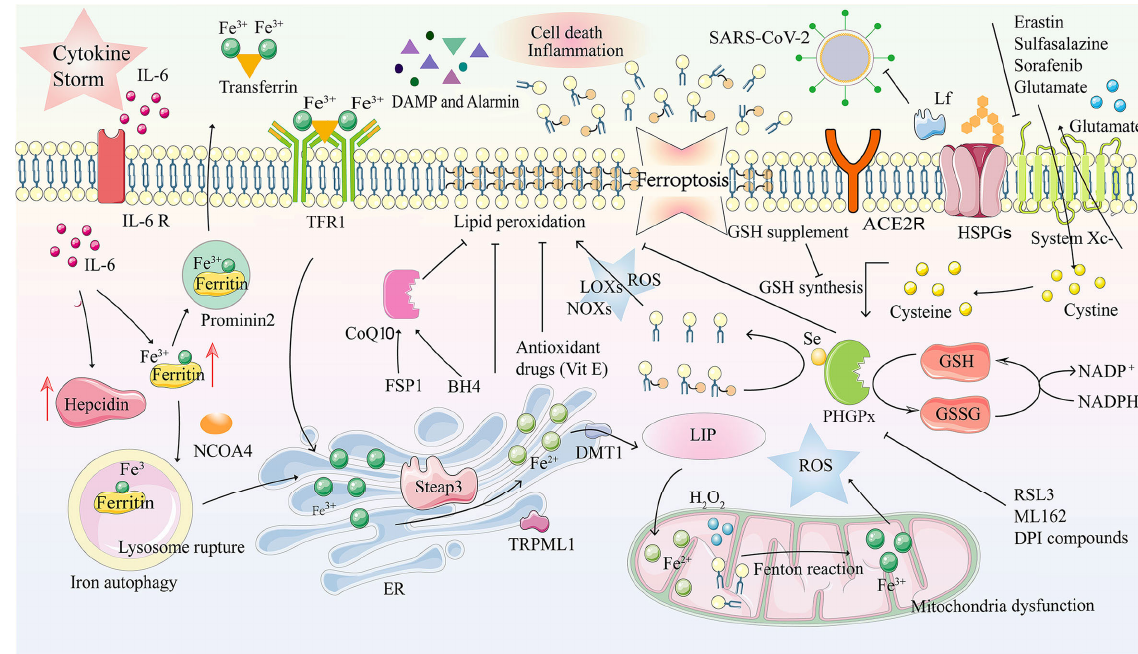
Figure 2. Ferroptosis and its mechanism in COVID-19. Ferroptosis is a kind of programmed cell death characterized by an imbalance in intracellular iron metabolism or a distortion of the glutathione peroxidation pathway. The transferrin receptor recognizes excess transferrin carrying Fe 3+ , and it enters cells through endocytosis after an SARS-CoV-2 infection. Metal reductase Steap3 reduces the Fe ions from trivalent to divalent, while the iron channels DMT1 and TRPML1 in the endosome membrane transport Fe 2+ to the cytoplasm, which is accompanied by iron accumulation. In the case of intracellular iron overload, chemical substances in the mitochondrial electron transfer chain react with H 2 O 2 , Fe 2+ and lipids, together, inducing the Fenton reaction, which produces large amounts of ROS. Due to GPX4 depletion and iron overload in LIP, lipid, nucleic acid and protein peroxidation results in cell membrane damage due to oxidative stress and ferroptosis. DAMPs and Alarmin (HMGB1, IL-33, TNF) are released, eventually aggravating cell death and inflammation. Tf and prominin 2 can effectively excrete the iron from the cells and inhibit ferroptosis. ACE2R, Angiotensin-converting enzyme 2 receptor; ALOXs, arachidonate lipoxygenases; BH4, tetrahydrobiopterin; CoQ10, coenzyme Q10; DAMP, damage-associated molecular patterns; DFO, deferoxamine; DMT1, divalent metal transporter 1; DPI, diphenyleneiodonium; ER, endoplasmic reticulum; FSP1, ferroptosis suppres- sor protein 1; GPX4, glutathione peroxidase 4; GSH, glutathione; GSSG, oxidized GSH; HMGB1, highmobilitygroupbox-1protein; HSPGs, heparan sulfate proteoglycans; H 2 O 2 , hydrogen peroxide; IL, interleukin; Lf, lactoferrin; LIP, labile iron pool; LOXs, lysyl oxidases; NADP + , nicotinamide adenine dinucleotide phosphate; NADPH, nicotinamide adenine dinucleotide phosphate; NCOA4, nuclear receptor coactivator 4; NOXs, NADPH oxidases; PLOOH, phospholipid hydroperoxide; PUFAs, polyunsaturated fatty acids; ROS, reactive oxygen species; RSL3, 1S,3R-RSL3; Se, selenocys- teine; Steap3, six-transmembrane epithelial antigen of prostate 3; TFR1, transferrin receptors 1; TNF, tumor necrosis factor; TRPML1, transient receptor potential mucolipin 1; VitE, vitamin E. Reproduced from [49] (Sun C et al.,